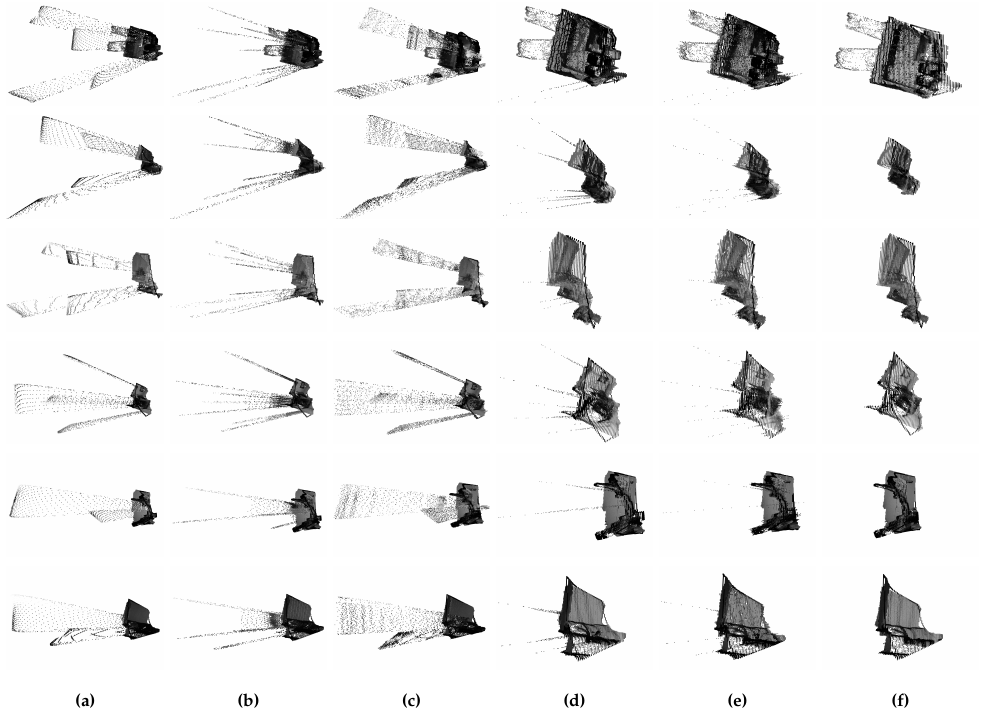
Figure 12. Left view of pointcloud. ( a ) Tthe original pointcloud. ( b ) The pointcloud of FMM. ( c ) The pointcloud of BBIM. ( d ) Ours (based on FMM). ( e ) Ours (based on BBIM). ( f ) Ground